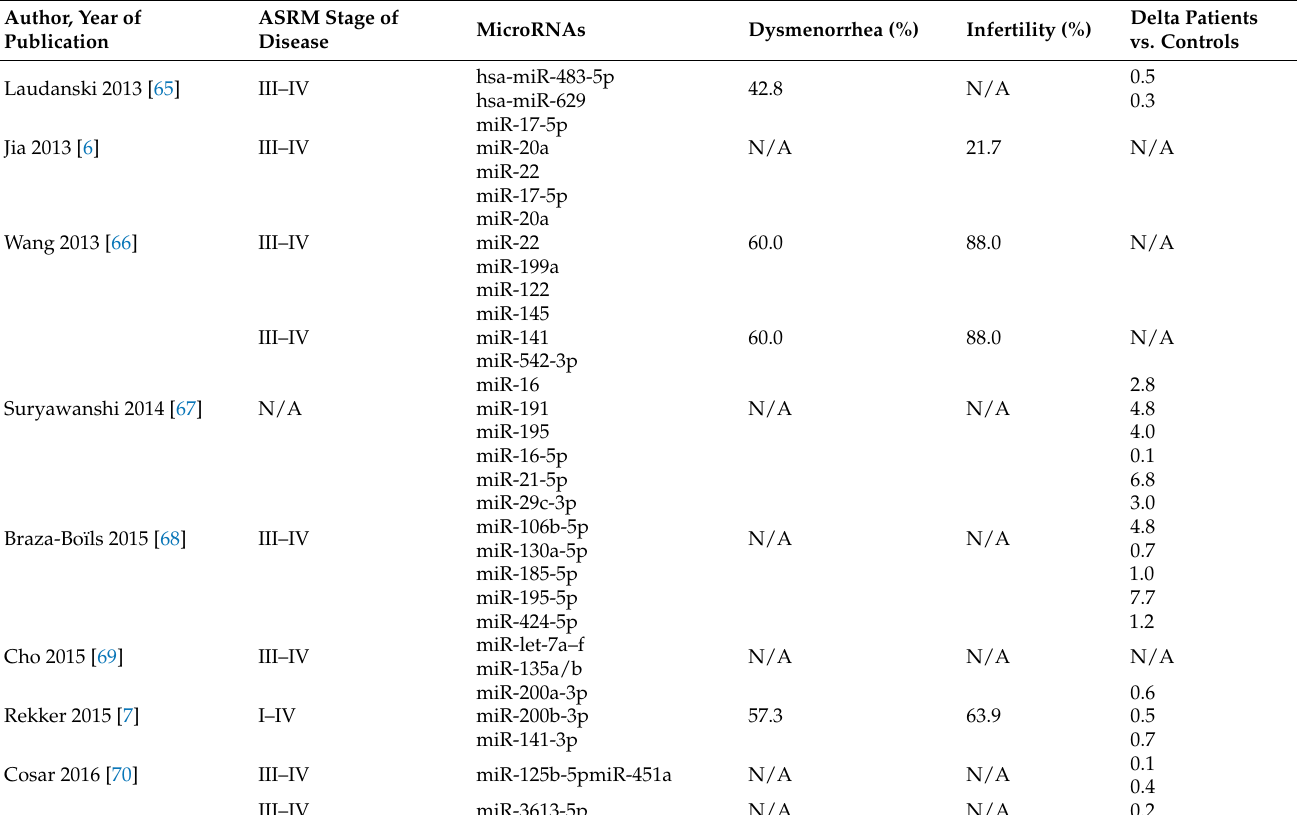
Table 4. MicroRNA modulation in